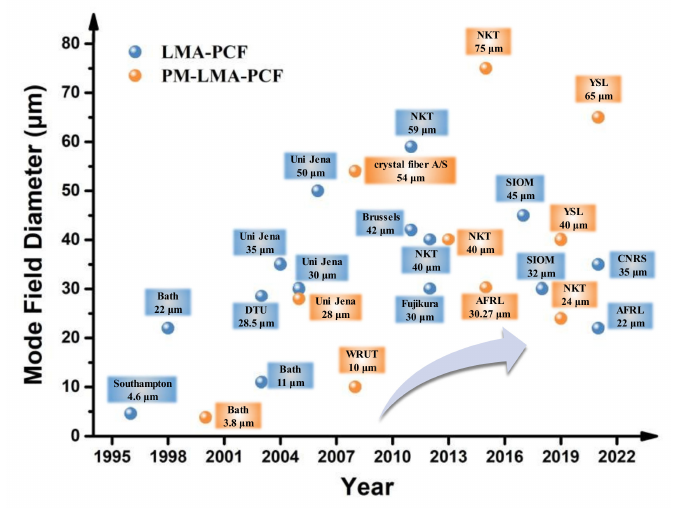
Figure 4. The landmark research advances in single-mode (SM) LMA-PCFs and polarization- maintaining (PM) LMA-PCFs from 1996 to 2021. Table 1. Specific parameters of the single-mode LMA-PCFs and PM-LMA-PCFs compared in Figure